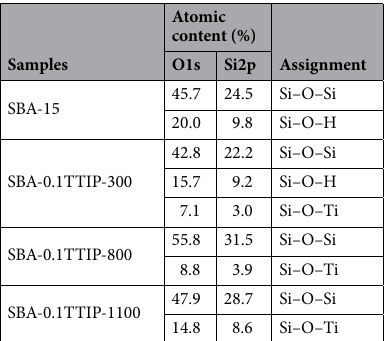
Table 2. Quantitative evaluation of atomic contents of O and Si in the samples from XPS